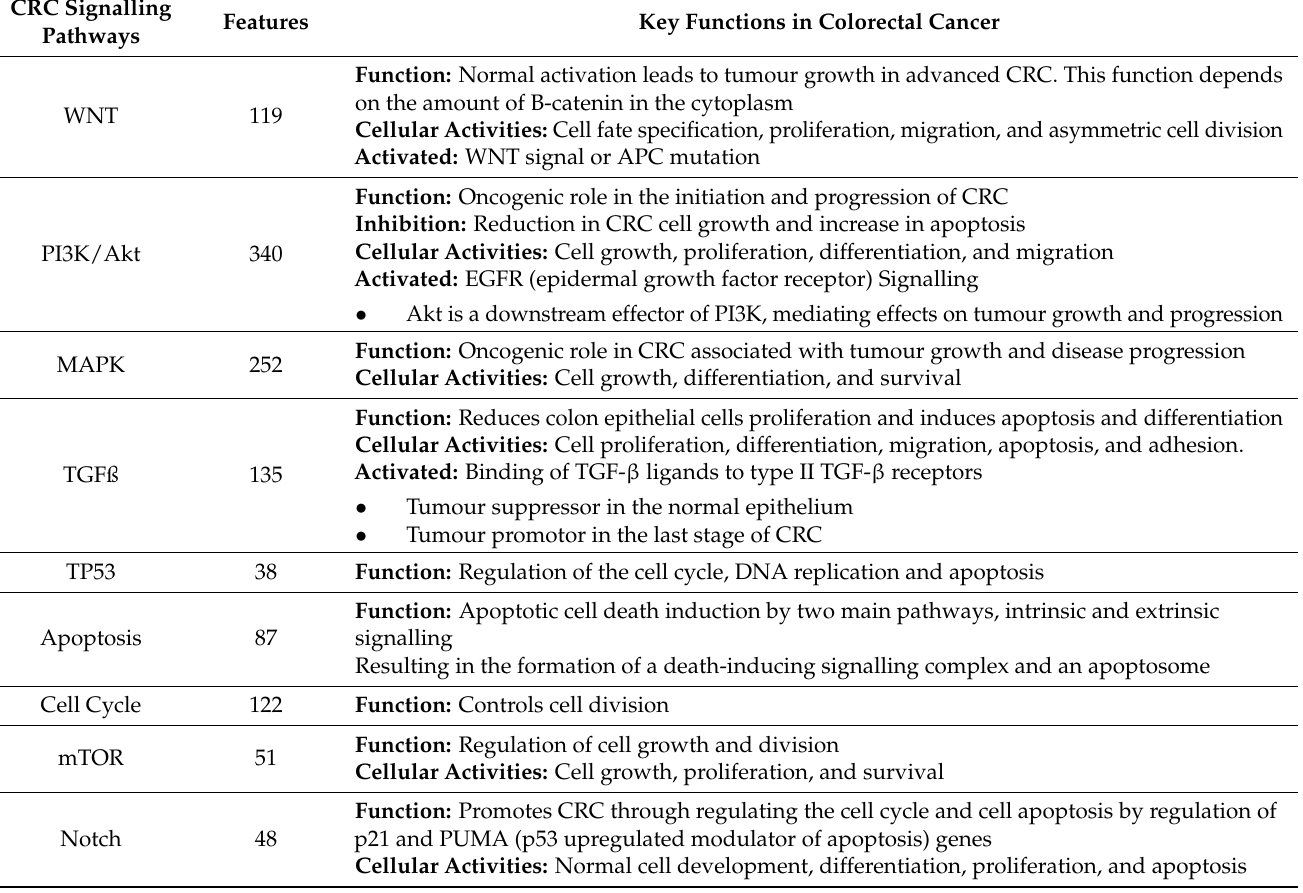
Table 1. Critical CRC STNs and the associated key functions. Nine major CRC STNs, WNT, Apoptosis, PI3K-Akt, TP53, MAPK, TGF-Beta, Cell Cycle, mTOR, and Notch are located in the first column. The “features” column represents the number of features within each STN, i.e., the number of genes in each pathway. The correlated key functions of each pathway in CRC are briefly explained in the third column [12–23]. Key Functions in Colorectal